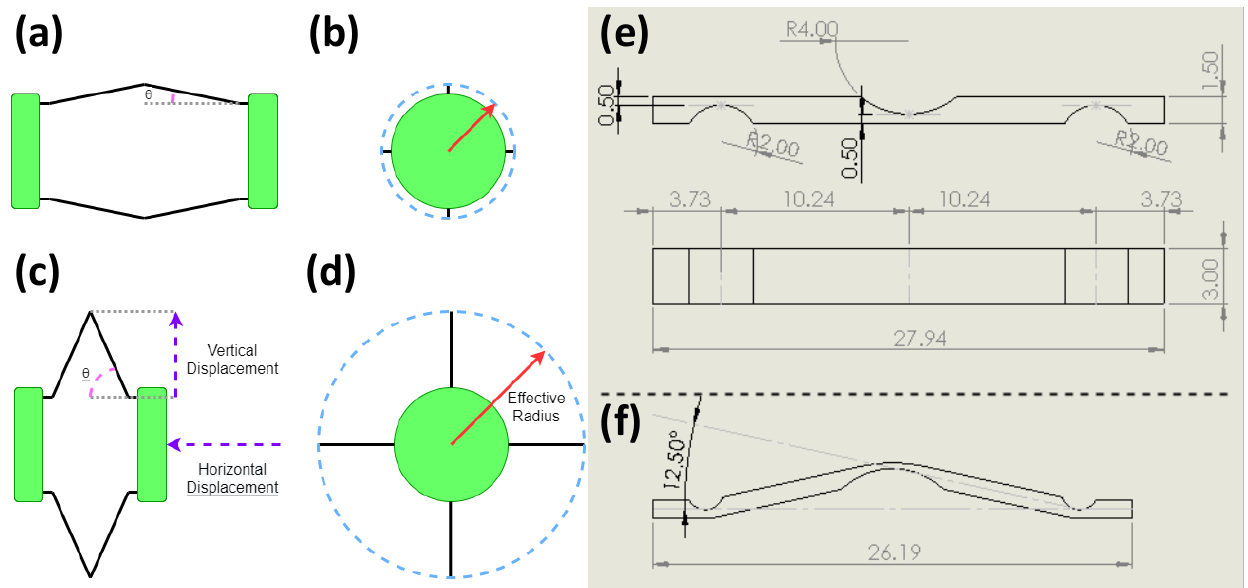
Figure 3. Design consideration of the anchoring mechanism. ( a ) Side view and ( b ) top view of the anchor in the resting state. ( c ) Side view and ( d ) top view of the anchor in the actuated state. The red arrow line in ( b , d ) indicates the effective radius of the contact points that interact with the intestinal wall. The green end caps are compressed together to extend the anchoring legs outside, shown in ( a , c ). Schematic leg design showing ( e ) Sarrus linkages. ( f ) Angle θ